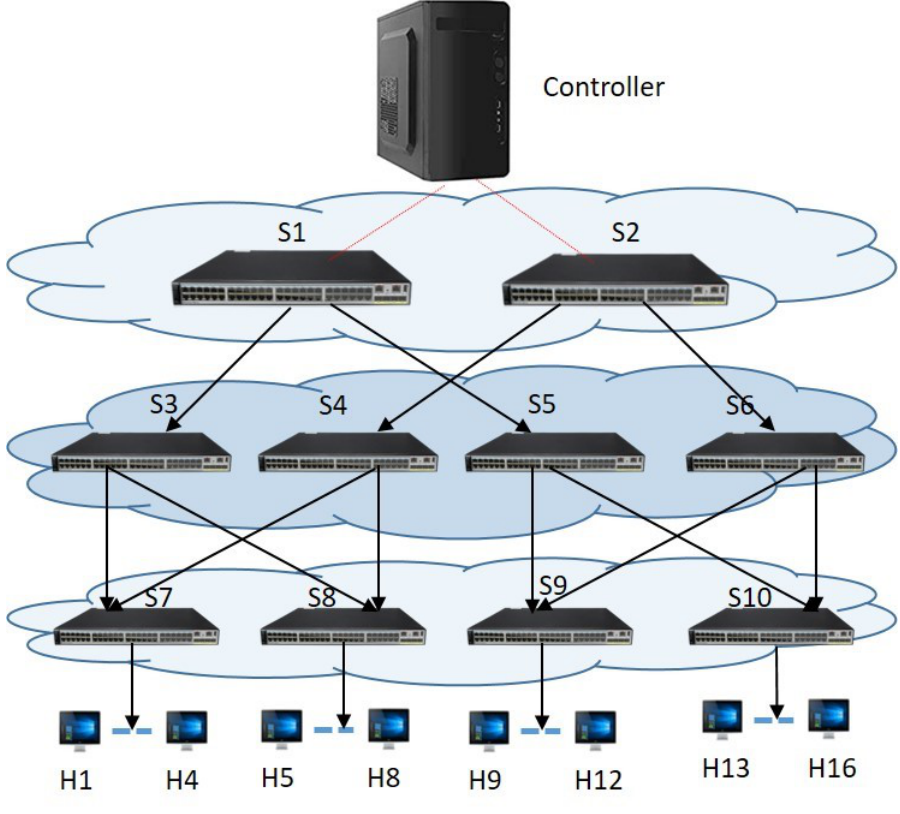
Figure 2. Modeled SDN tree